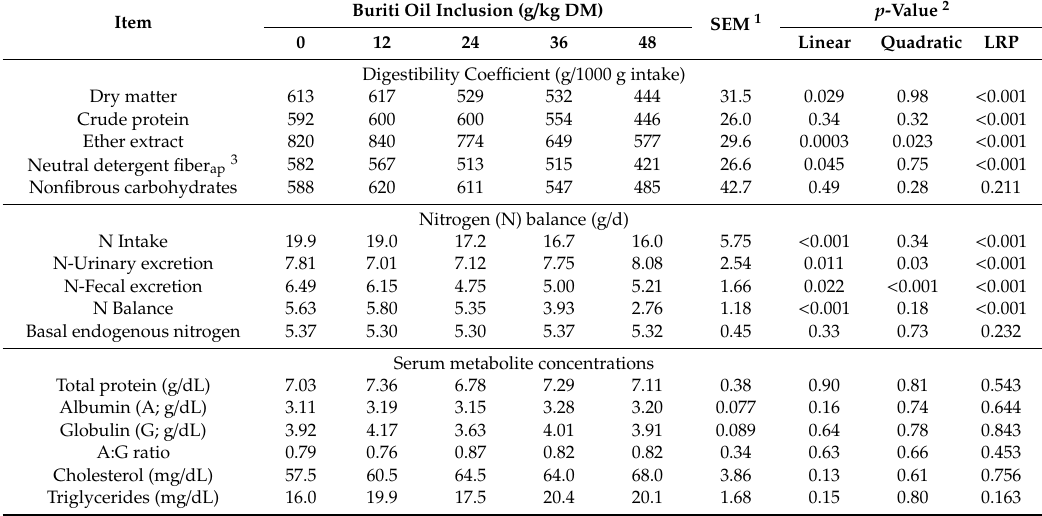
Table 5. Digestibility coe ffi cient, N balance and serum metabolites of Santa Ines lambs fed diets with buriti ( Mauritia flexuosa L.)